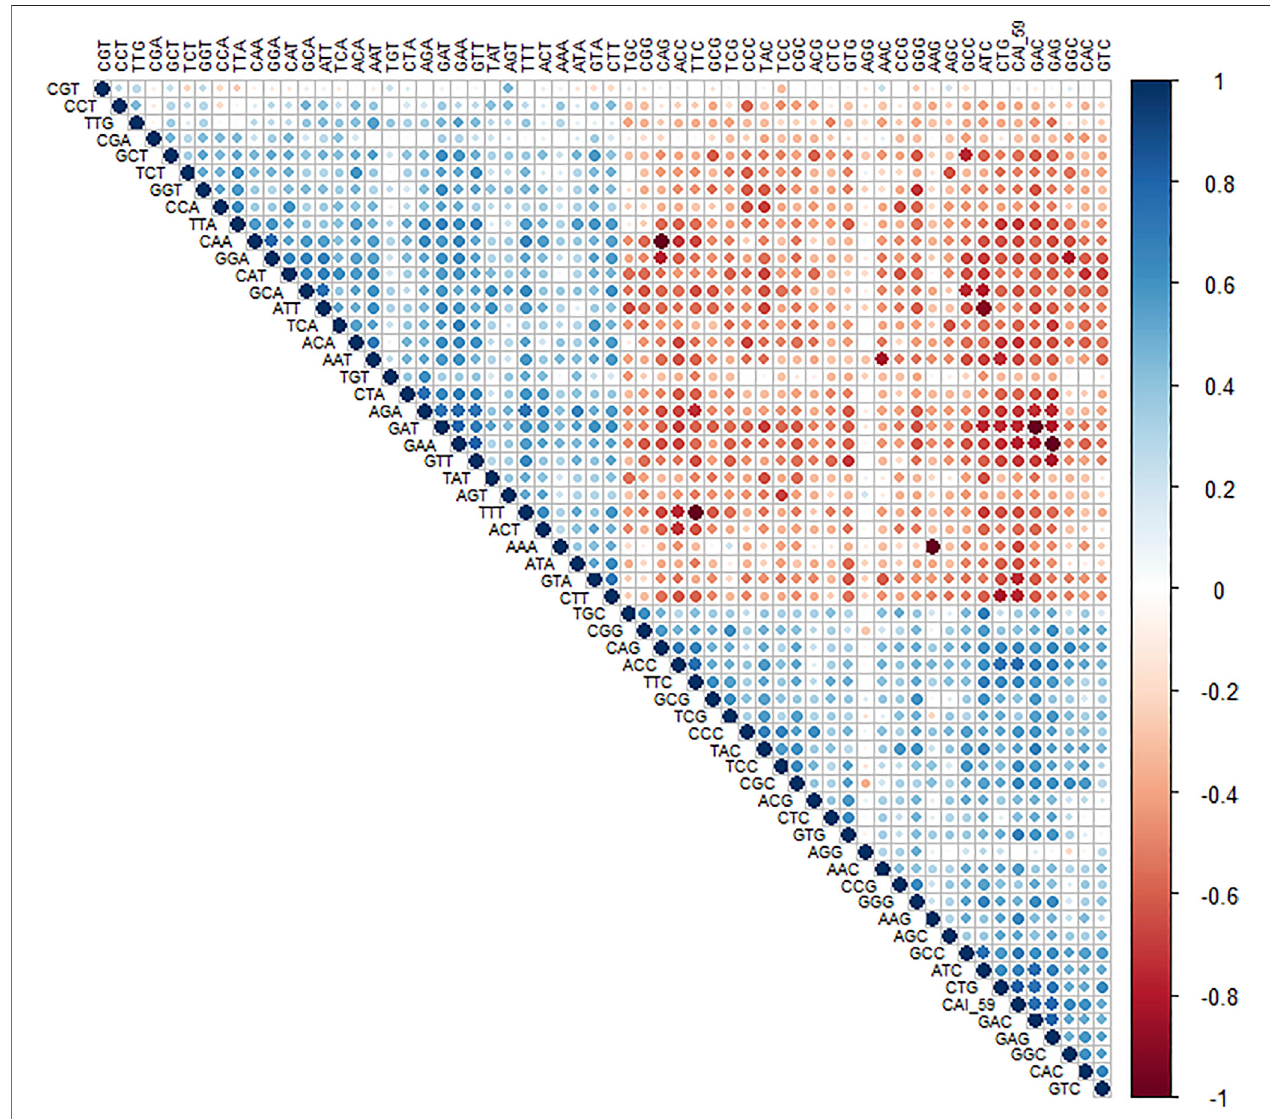
FIGURE2| CorrelationanalysisofRSCUvaluesofacodonandCAIvalue.Apositivecorrelationisbluecircles,whileanegativecorrelationisdepictedasredcircles. The level of signi fi cance was at 0.05%.